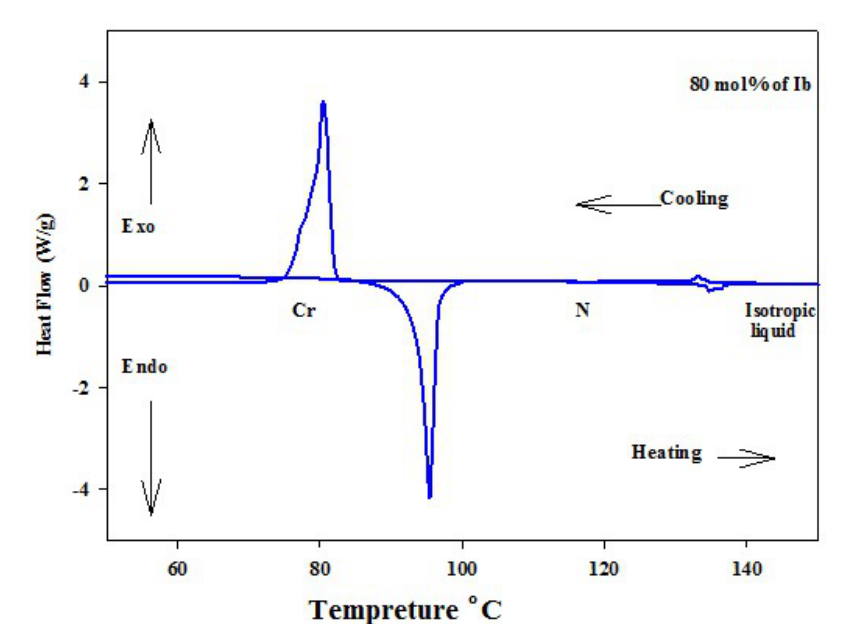
Figure 1. Differential scanning calorimetry (DSC) thermograms of binary mixture 80 mol% Ib for system Ib/Id upon the second heating/cooling cycles with a rate of 10 °C /min.